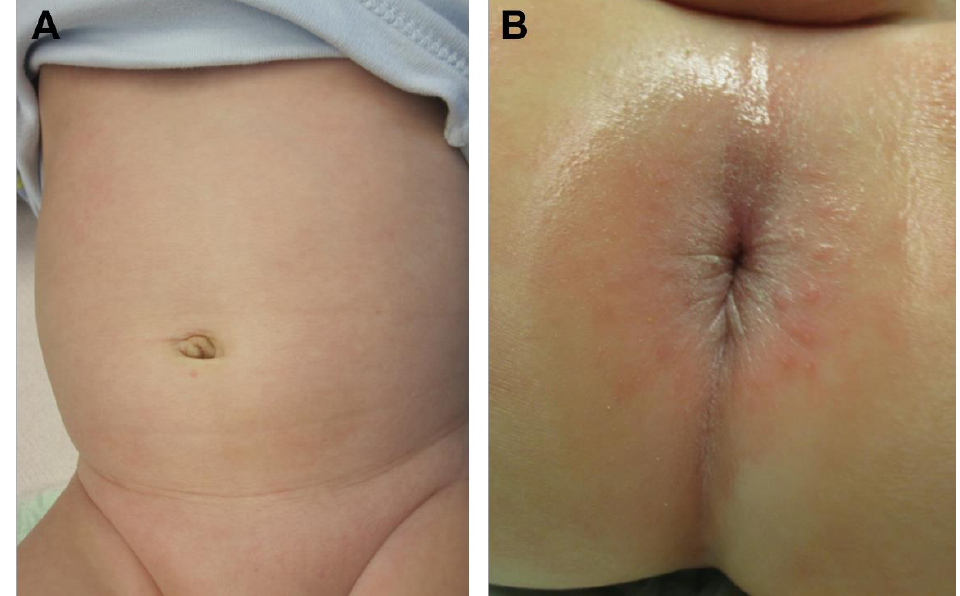
Figure 6. The cosmetic and functional outcome is excellent ( A ). The anal inspection is inconspicuous 167 ( B